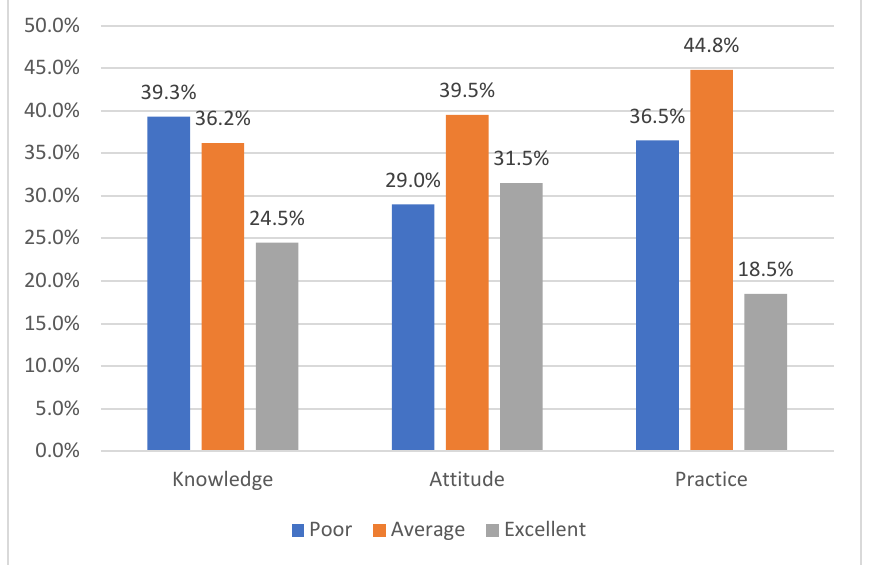
Figure 1. KAP categories for INCS usage among the AR patients ( n = 400).